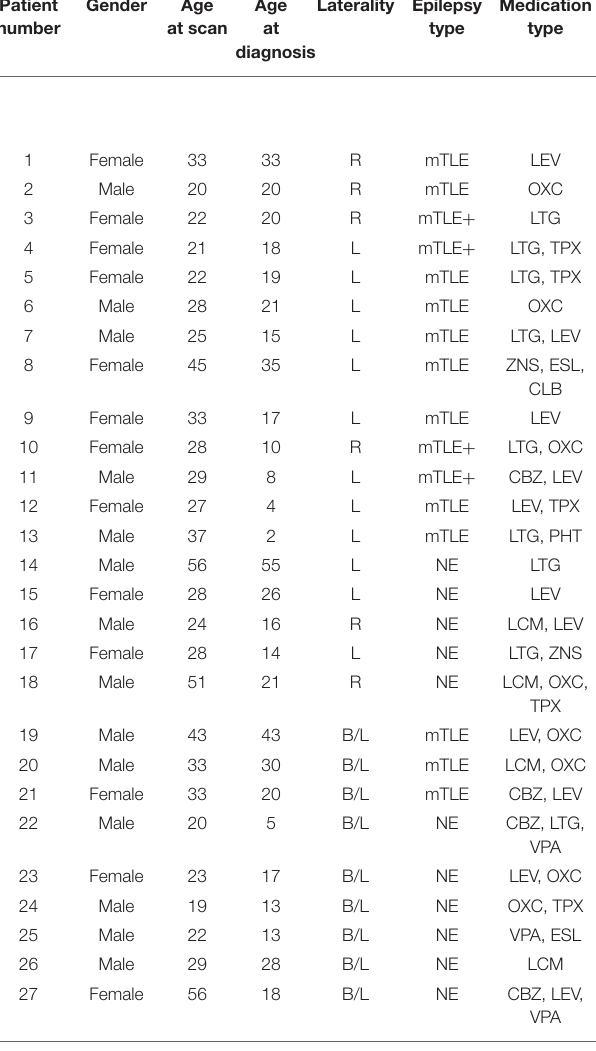
TABLE 1 | Patient